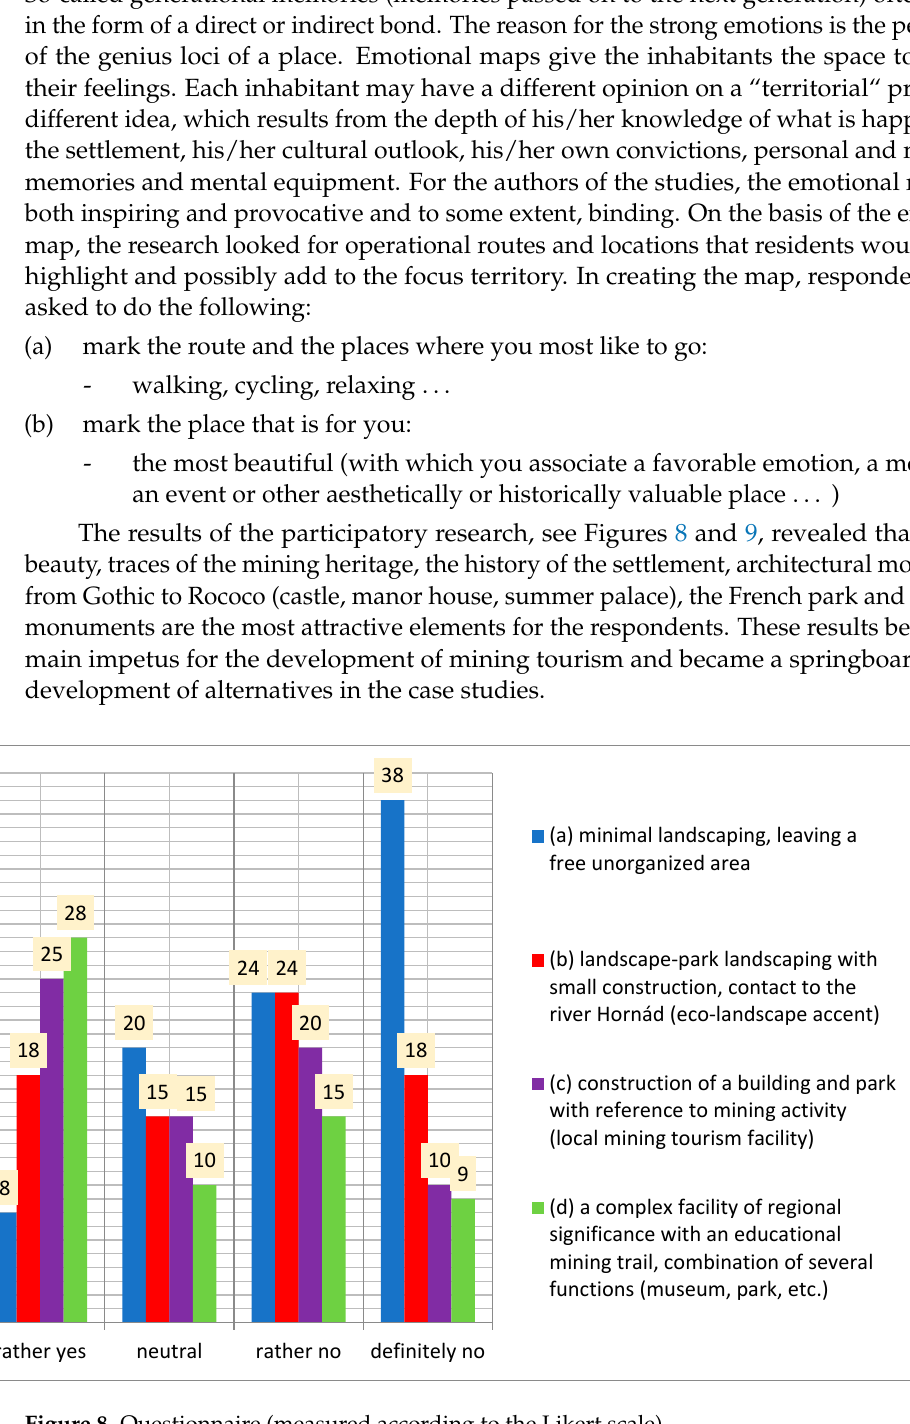
Figure 8. Questionnaire (measured according to the Likert scale).